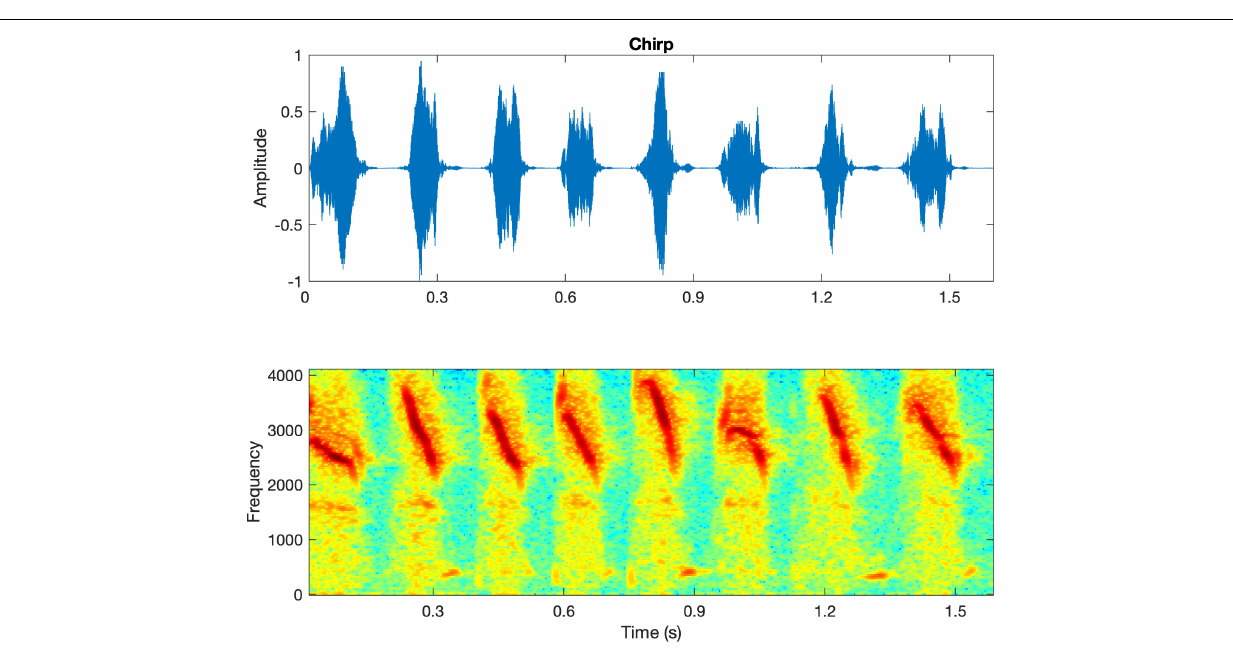
FIGURE 2 | The waveform and spectrogram of the bird chirps. The spectrogram shows that the chirps are rapid downward frequency sweeps from 4000 to 2,000 Hz